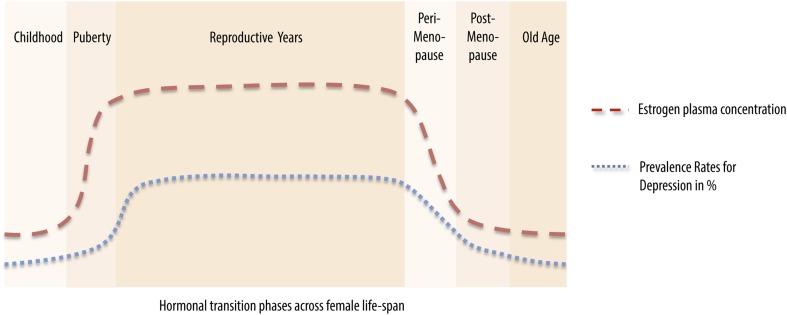
Vulnerability for development of a depressive illness corresponds to main hormonal transitions across the female lifespan. During childhood (0–9 years), a phase associated with low estrogen plasma levels, the prevalence rate for depression ranges between 2 and 3% (Kashani et al., 1983; Lewinsohn et al., 1994). When estrogen levels start rising in puberty (10–15 years), so does the prevalence rate for depression, up to 8% (Angold et al., 1998). During reproductive years, a phase when estrogen and progesterone levels peak, prevalence rates vary between 21 and 38% (Kessler et al., 1993; Angold et al., 1998). Estrogen and progesterone levels start declining during perimenopause (41–51 years), drop considerably postmenopausally (45–65 years) and remain fairly stable during old age (above 65 years). This drop in sex steroid levels is paralleled by a decrease in prevalence rates for depression from 23 to 26% (Cohen et al., 2006a; Freeman et al., 2006; Unsal et al., 2011; Tamaria et al., 2013) during the hormonal transition phases to rates of 1–5% during old age (Tamaria et al., 2013).